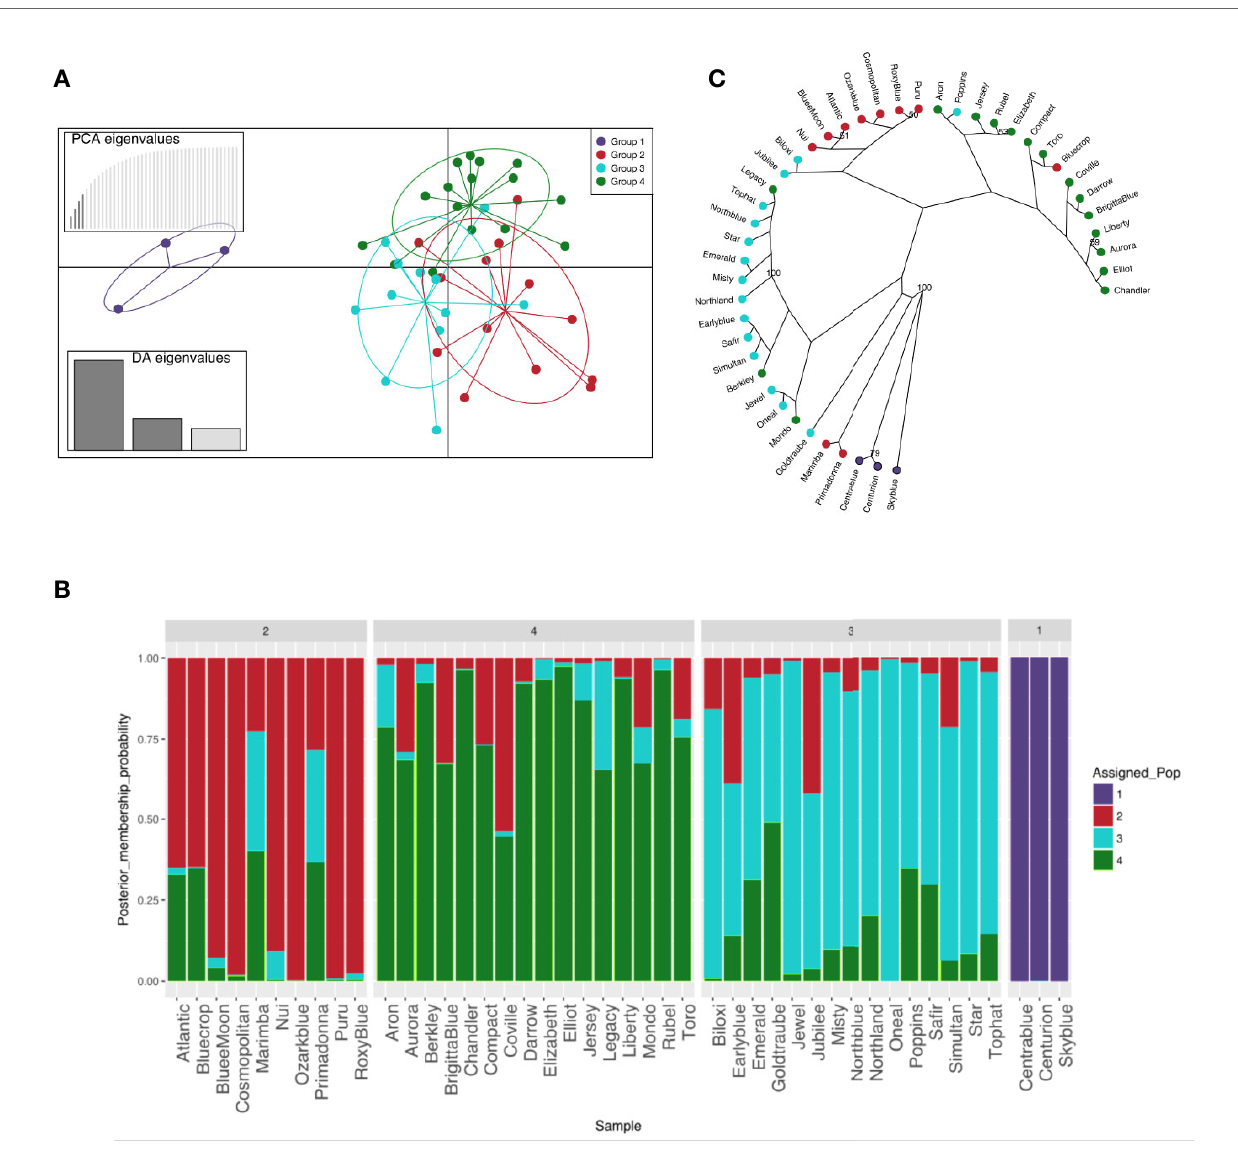
FIGURE 1 | Genetic structure of the 44 blueberry samples evaluated with six SSR. (A) Discriminant analysis of principal components (DAPC). (B) STRUCTURE-like plot of DAPC analysis for a global picture of the clusters composition. Each individual is represented by a vertical coloured line. Same colour in different individuals indicates that they belong to the same cluster. (C) Radial dendrogram based on Bruvo ’ s